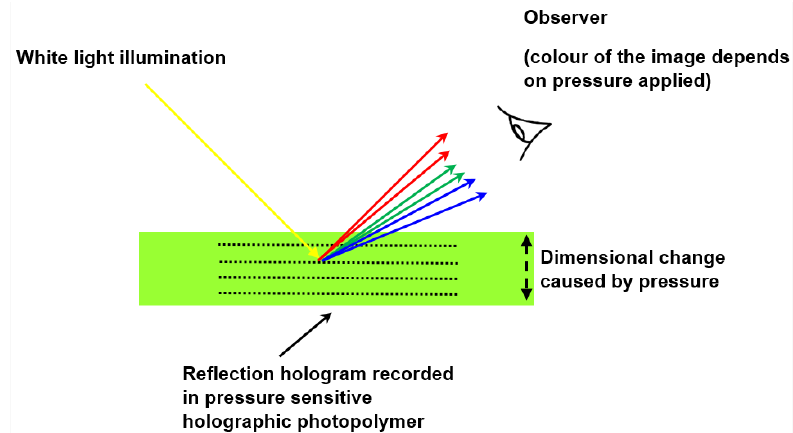
Figure 5. Principle of operation of a holographic pressure sensor.